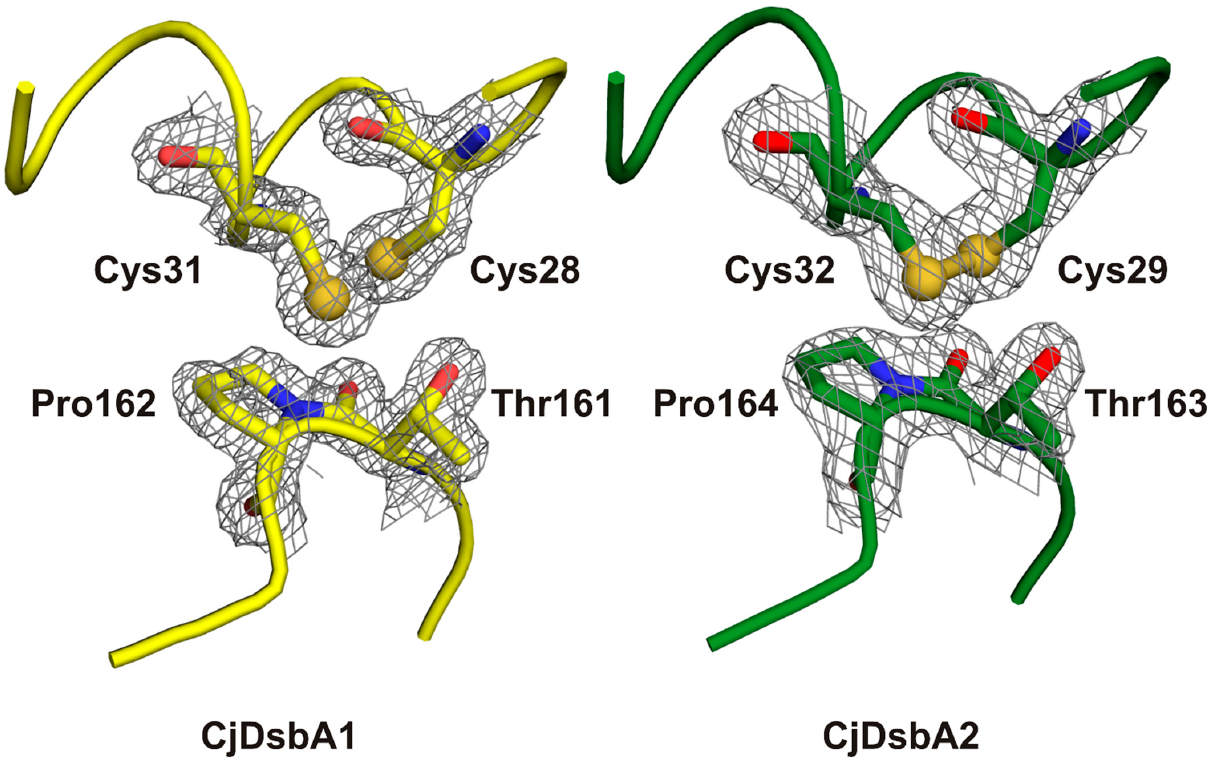
Figure 9. Active site of CjDsbA1 ( left ) and CjDsbA2 ( right ) exhibits different oxidation states. Selected residues are shown as sticks and 2fo–fc composite omit maps countered at 2 σ level are shown as grey mesh.